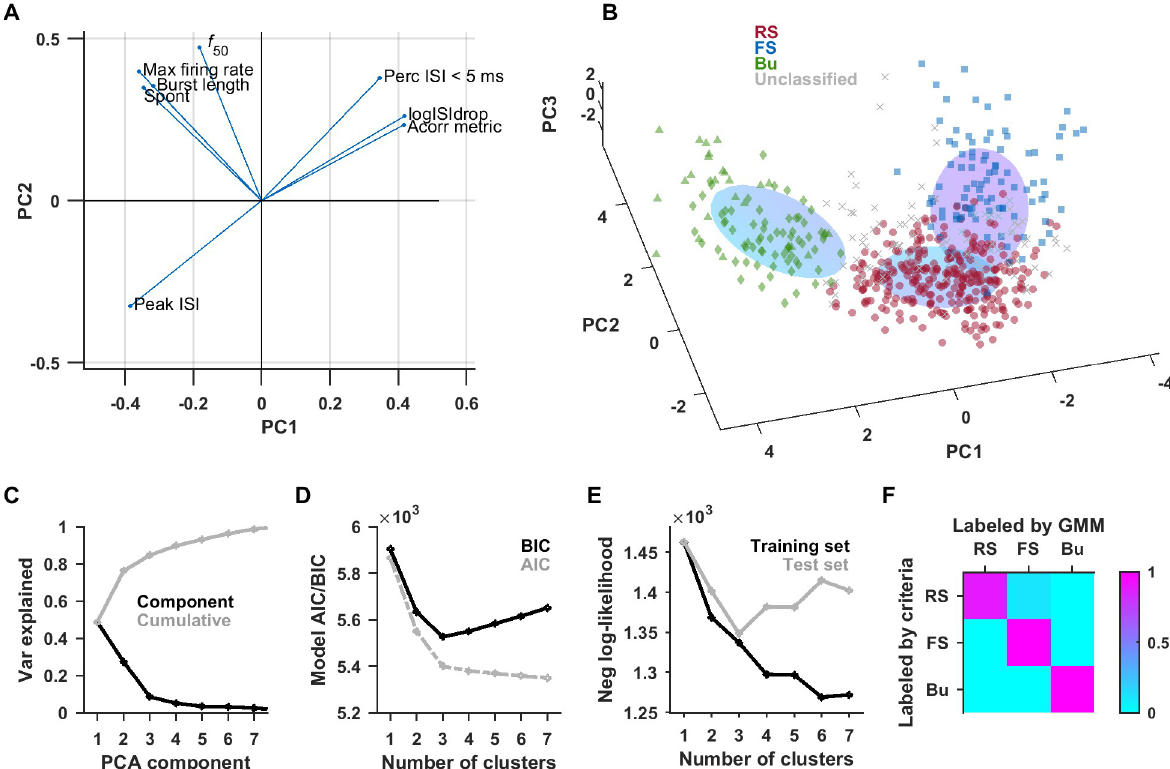
Fig 3. Unsupervised classification also detects 3 major classes with strong agreement with criteria-based classification. PCA was performed on a set of 8 features. The loading plot (A) revealed 2 main subsets of features, those pertaining to spike timing and burstiness, and those pertaining to fast spiking. We fit a 3-component GMM to the first 3 PCA components (B). The color of the points indicates the labels assigned by the previous method using criteria (triangular and diamond markers indicate Bu1 and Bu2 subgroups, respectively). The elongated ovoids represent the 3D contours of each of the 3 components of the GMM at half height. (D) The plot of the AIC and BIC versus number of components both support the choice of 3 components. (E) The data set was split into training and test sets (repeated 20 times), and the negative log-likelihood was calculated as a proxy for quality of fit. The negative log-likelihood increased after 3 components for the test set, suggesting that more than 3 components resulted in overfitting. (F) The confusion matrix between the type labels assigned by criteria and GMM showed high agreement. Data underlying this figure can be found in S1 Data. AIC, Akaike information criterion; BIC, Bayesian information criterion; GMM, Gaussian mixture model; PCA, principal component analysis.